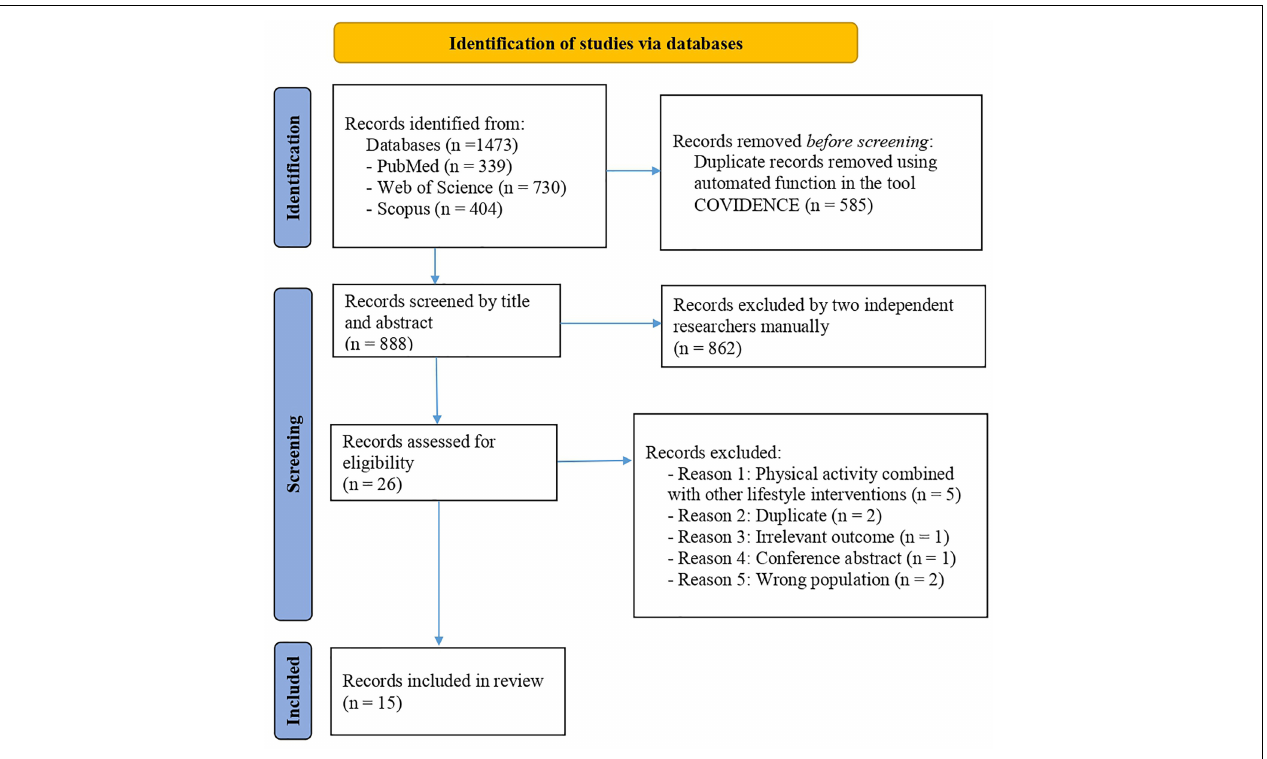
FIGURE 1 | Study selection process based on the Preferred Reporting Items for Systematic Reviews and Meta-Analyses (PRISMA) 2020 flow